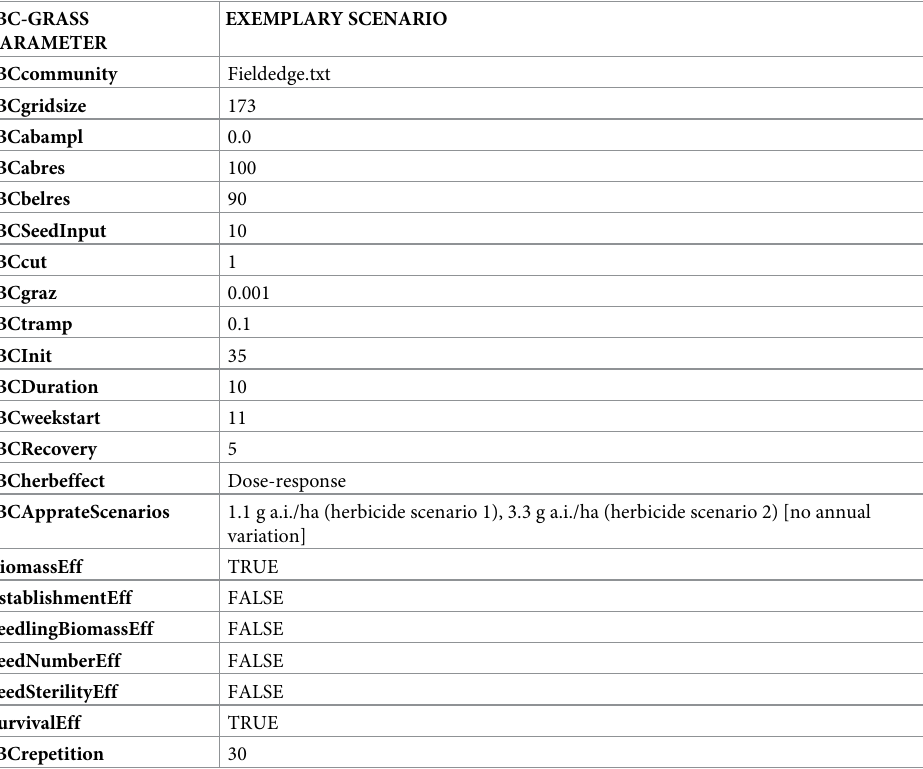
Table 4. Summary of simulation settings for the presented exemplary scenario in which herbicide effects are based on dose response data. The second exemplary scenario can be found in the software package